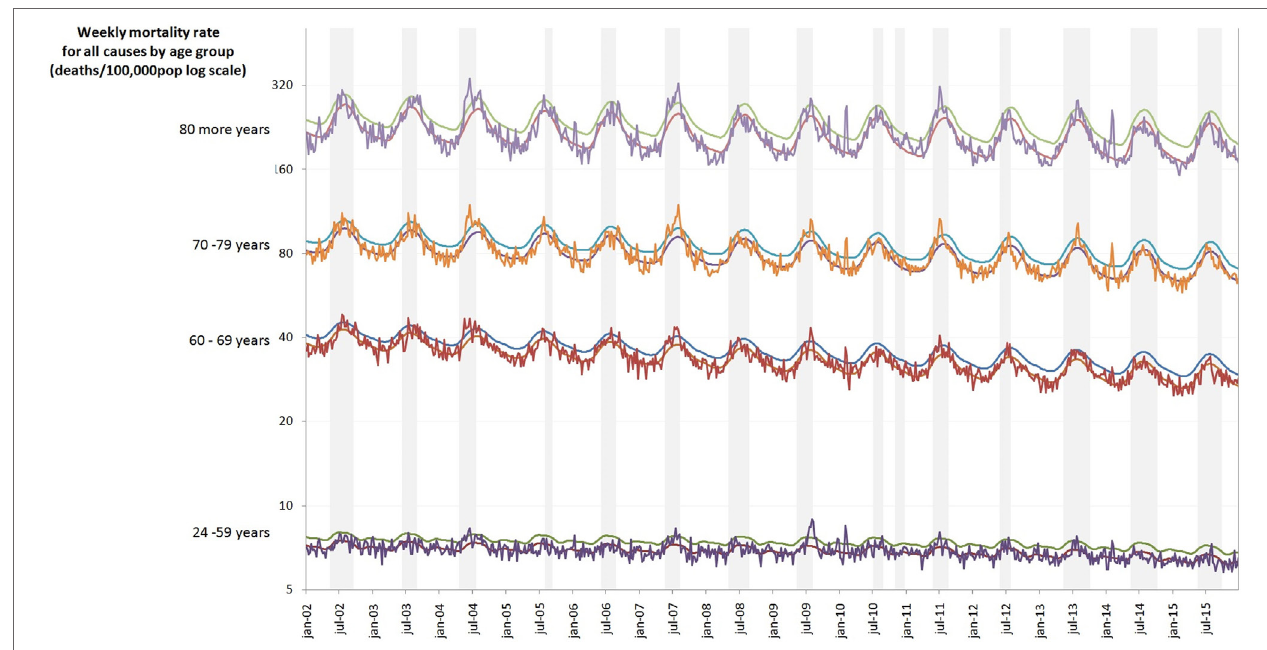
FigUre 1 | Weekly mortality rate by age group (deaths/100,000) log scale in southern regions of Brazil, 2002–2015. Colored lines are age groups and gray columns are the seasons of